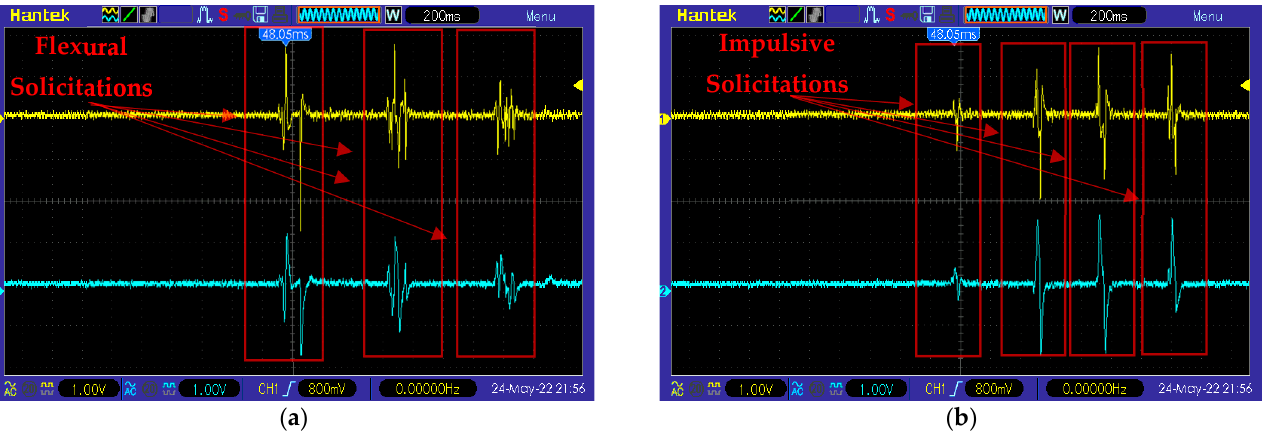
Figure 29. Waveforms of the output signal V out (yellow trace) and the filtered output signal V out, filtered (cyan trace) in response to the flexural ( a ) and impulsive ( b ) solicitations.